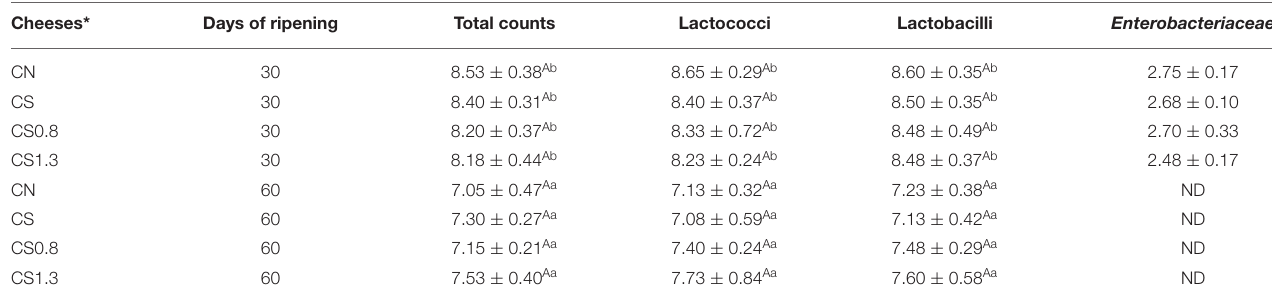
TABLE 6 | Microbiological results (log cfu g − 1 cheese) of reduced-sodium cheeses by substituted-sodium treatment (CS) at 30 and 60 days of ripening. Cheeses* Days of ripening